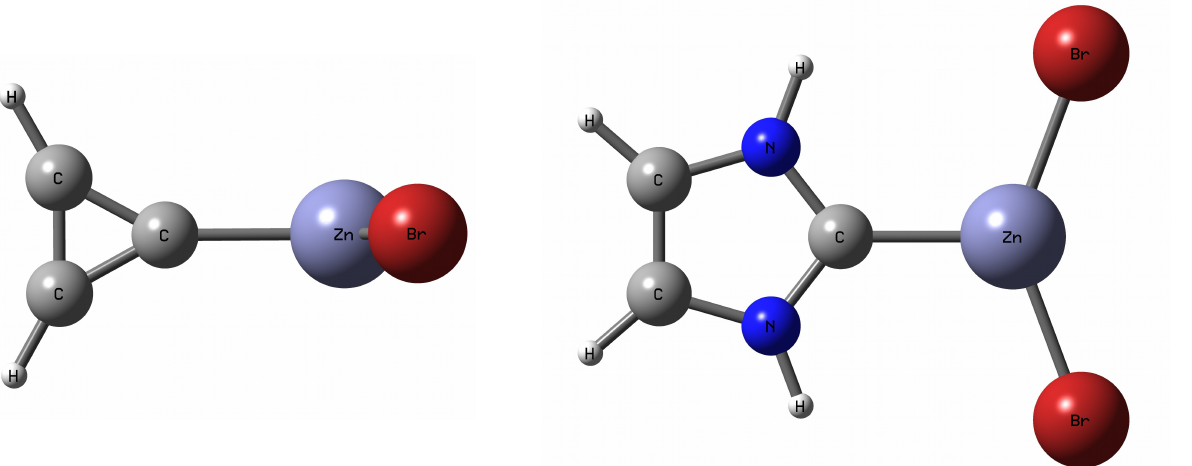
Figure 1. Fully optimized cyclopropenylidene · · · ZnBr 2 ( left ) and imidazol-2-ylidene · · · ZnBr 2 ( right ) dimer